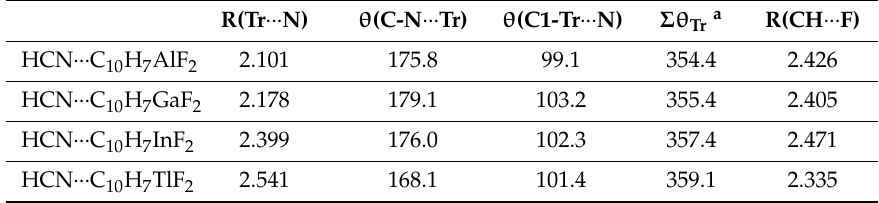
Table 3. Structural parameters (distances in Å, angles in degrees) in complexes of C 10 H 7 TrF 2 with NCH calculated at the MP2 / aug-cc-pVDZ level of